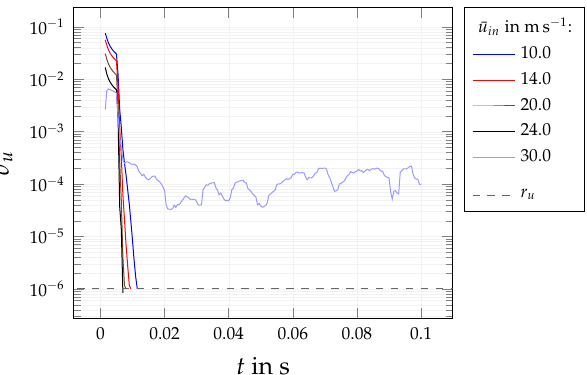
Figure 12. Transient development of velocity convergence with a resolution of N = 96 for different inflow velocities ¯ u in . Dashed line represents residuum r ¯ u .